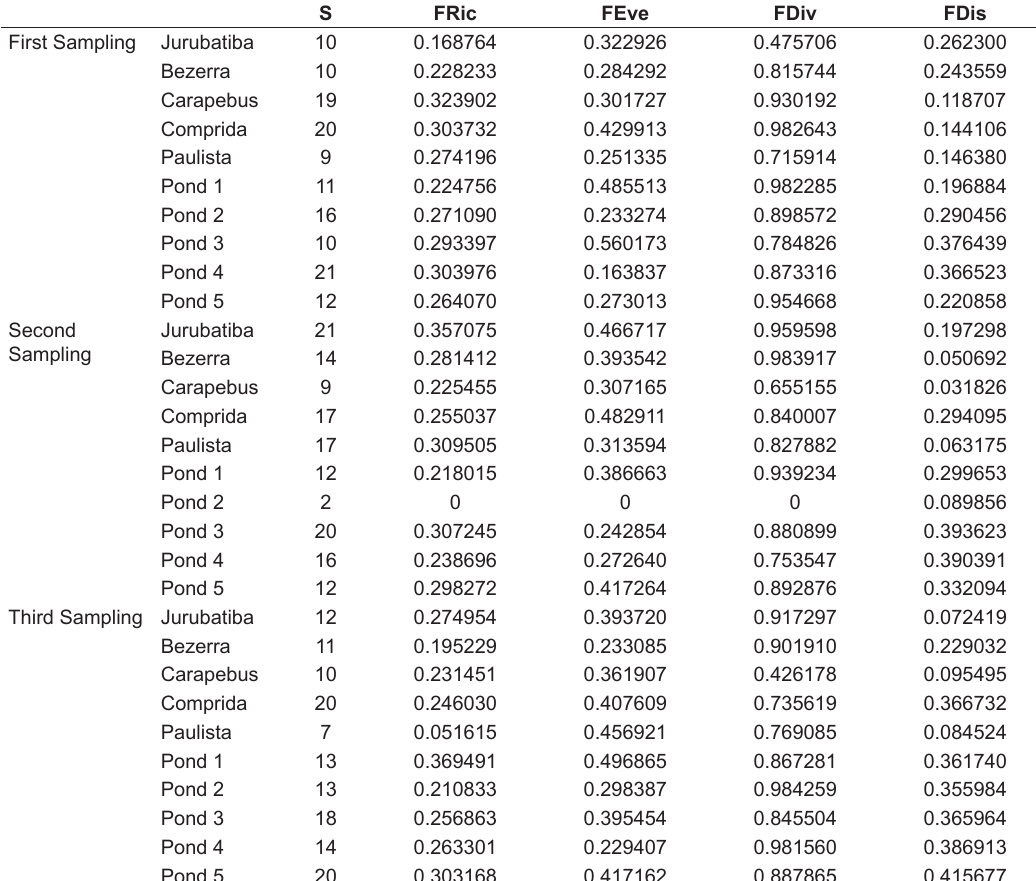
Table 4. Data of Richness (S), Functional Richness (FRic), Functional Evenness (FEve), Functional Divergence (FDiv) and Functional Dispersion (FDis) observed in the temporary ponds and permanent lagoons located within Restinga de Jurubatiba National Park, Rio de Janeiro, Brazil. Samples were taken in 6 and 20 of April and 13 of May 2010, respectively.